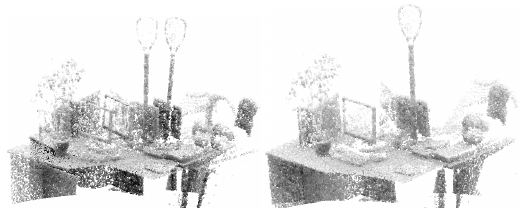
Figure 10: Illustration of the proposed ICP optimal variant for the TLS dataset, colored using ambient occlusion. Left: before registration. Right: after registration. No shift can be noticed.